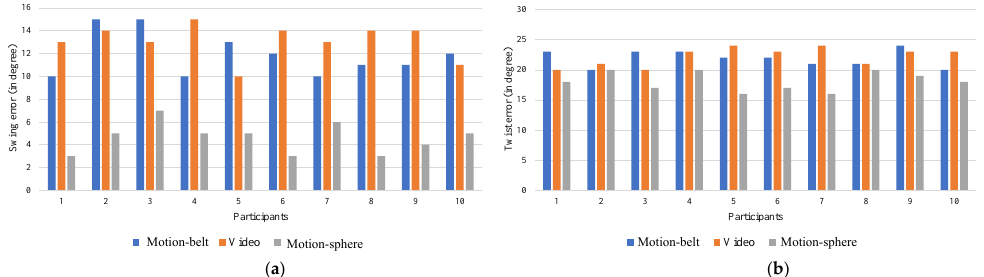
Figure 14. ( a ) Average participant’s swing prediction error against the ground truth ( b ) Average participant’s twist prediction error against the ground truth, for Motion-belt, Video and Motion-sphere.